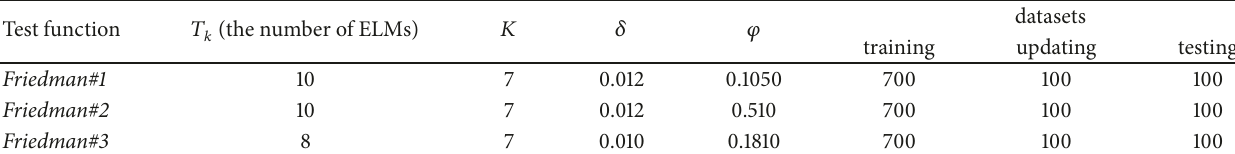
Table 5: Parameters of the algorithmic performance